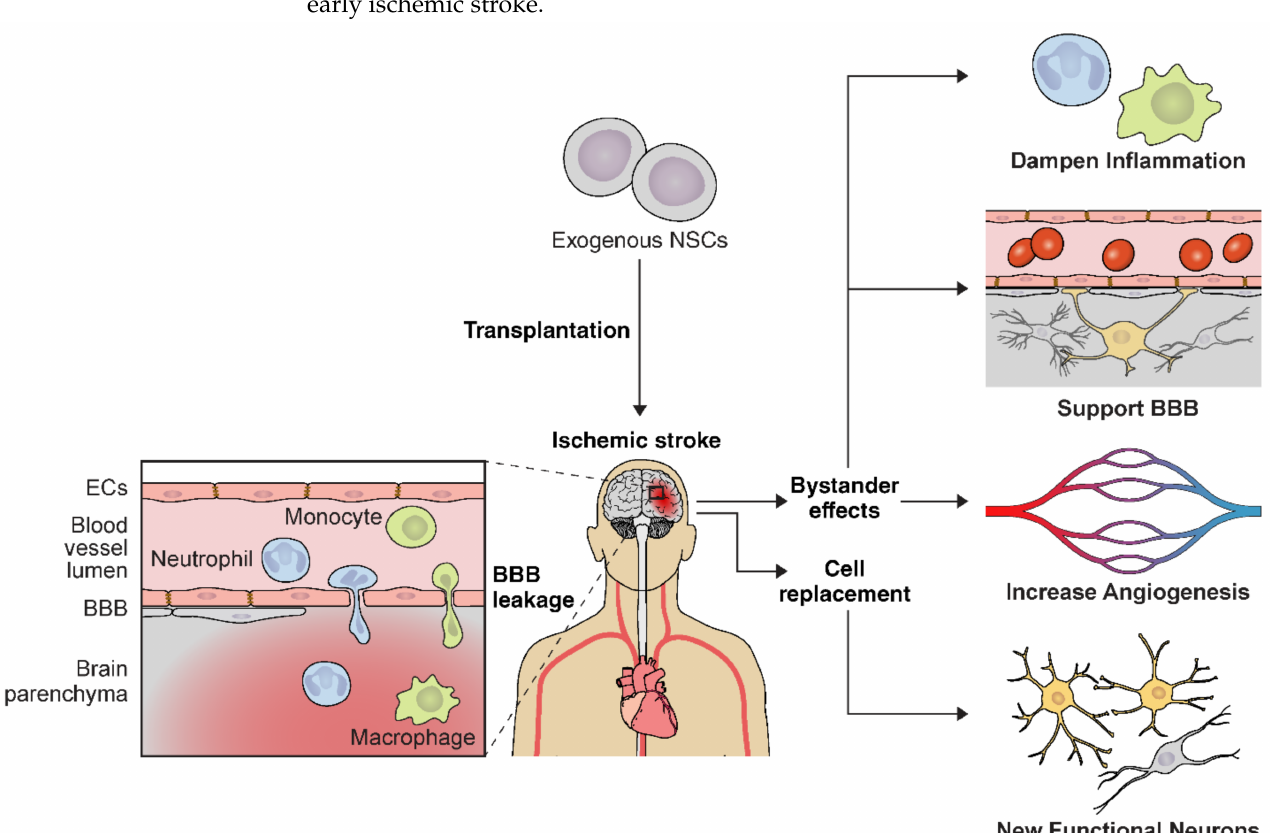
Figure 2. Schematic diagram of NSC delivery illustrating multiple therapeutic mechanisms in ischemic stroke. NSCs can differentiate into functional neurons in the stroke brain and possess pleotropic bystander effects. These bystander effects include attenuation of blood-brain barrier (BBB) disruption, increased angiogenesis, and modulation of immune responses after ischemic stroke. ECs, endothelial